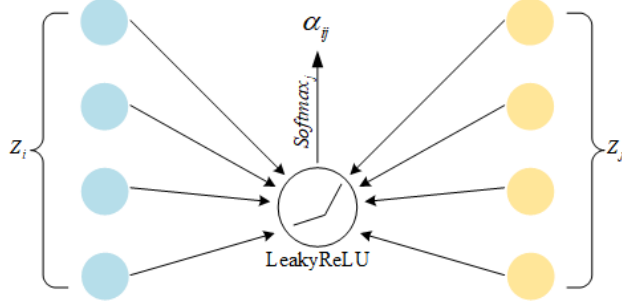
Figure 5. Attention